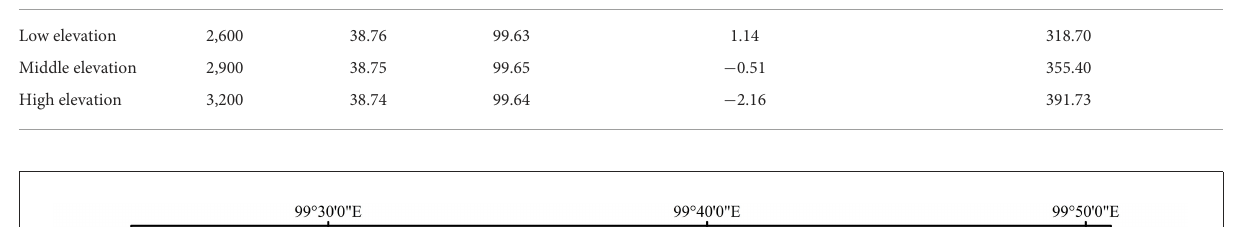
TABLE 1 Basic information of the sampling sites.